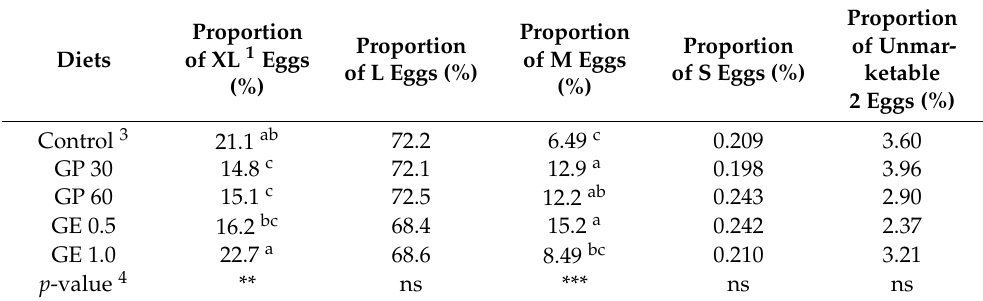
Table 4. Effect of grape pomace (GP) and grape extract (GE) at different dietary concentrations (g/kg) on the proportion of the different size classes of eggs in 50- to 54-week-old laying hens. Proportion Diets of XL 1